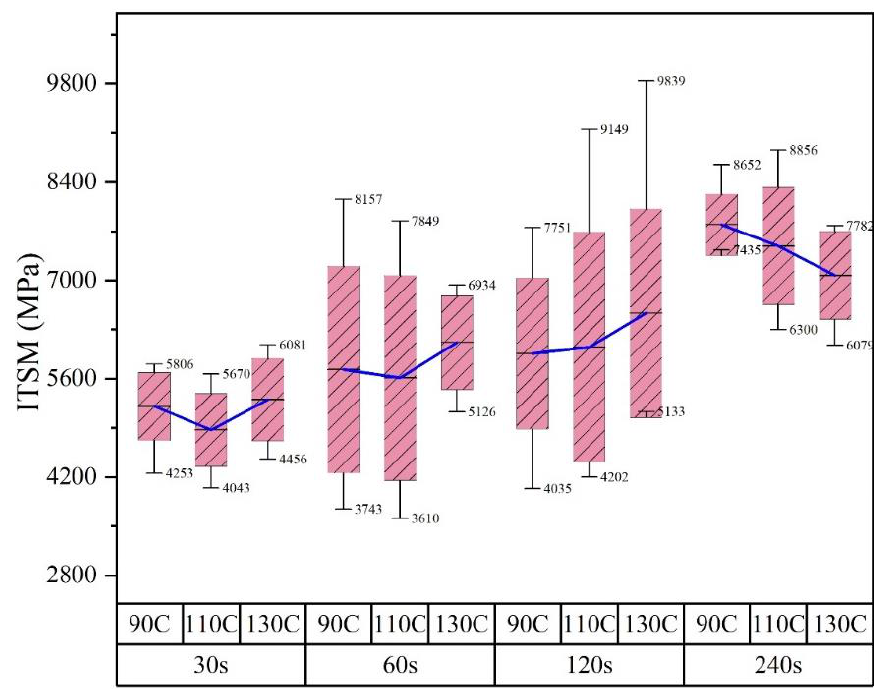
Figure 9. The stiffness values versus mixing temperature at different mixing times.